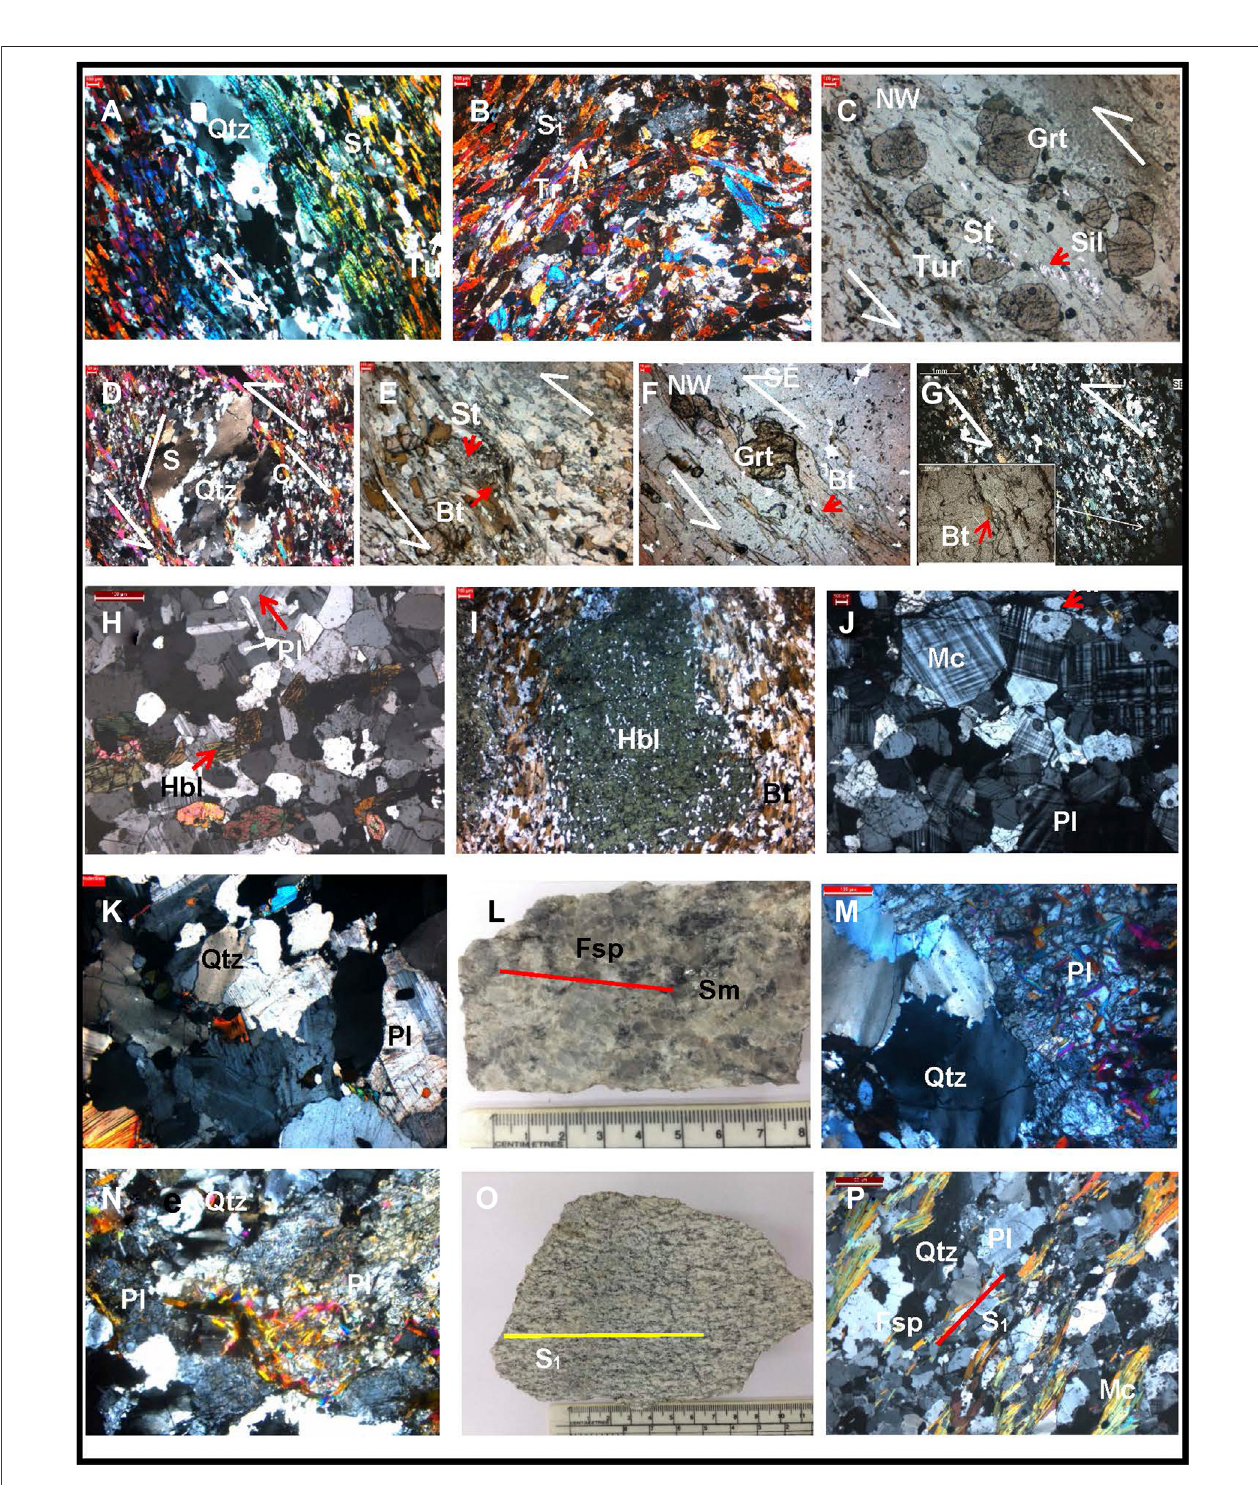
FIGURE 4 | Photomicrographs: (A) Mica schist with alternate muscovite + biotite and quartz rich layers, parallel to S 1 . (B) Calc schist with tremolite, arranged parallel to S 1 , the S 1 is folded by F 2 fold. (C) Garnet (Grt), staurolite (St), sillimanite (Sil), and tourmaline (Tur) assemblage in pelitic gneiss-tectonic slivers within metaconglomerate formation. Due to shearing along Phulad thrust, garnets show rotation in top-to-NW reverse sense. (D) Mica mylonite from Pratapgarh thrust, the quartz (Qtz) shows dynamic recrystallization, S fabric is indicated by long axis of the quartz, top-to-NW reverse sense of shearing, S ^ C is nearly 60 ° suggesting volume gain. (E) Staurolite changing to biotite (Bt) during shearing, Biotite is grown in the strain shadow of the staurolite porphyroclast, top-to-NW reverse sense of shearing. (F) Garnet porphyroclasts in the Phulad thrust show top-to-NW reverse slip, biotite develops in the tail of the porphyroclast, relict sillimanite (Sil) is present. (G)